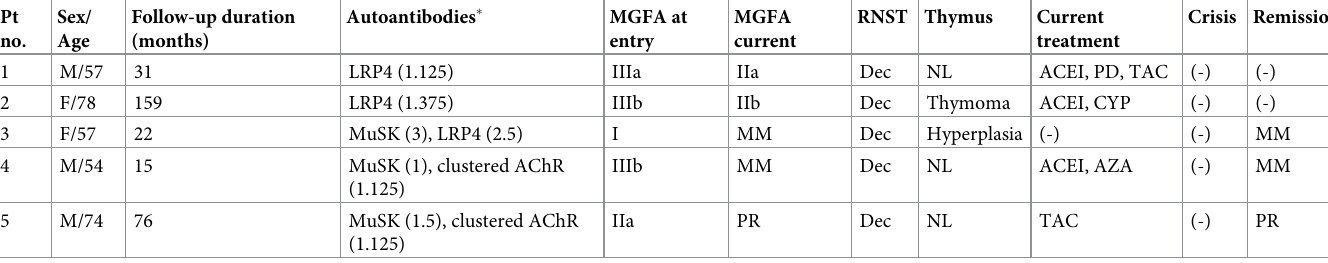
Table 2. Clinical features of the patients with the LRP4 antibody, and of the patients who were double seropositive. Pt